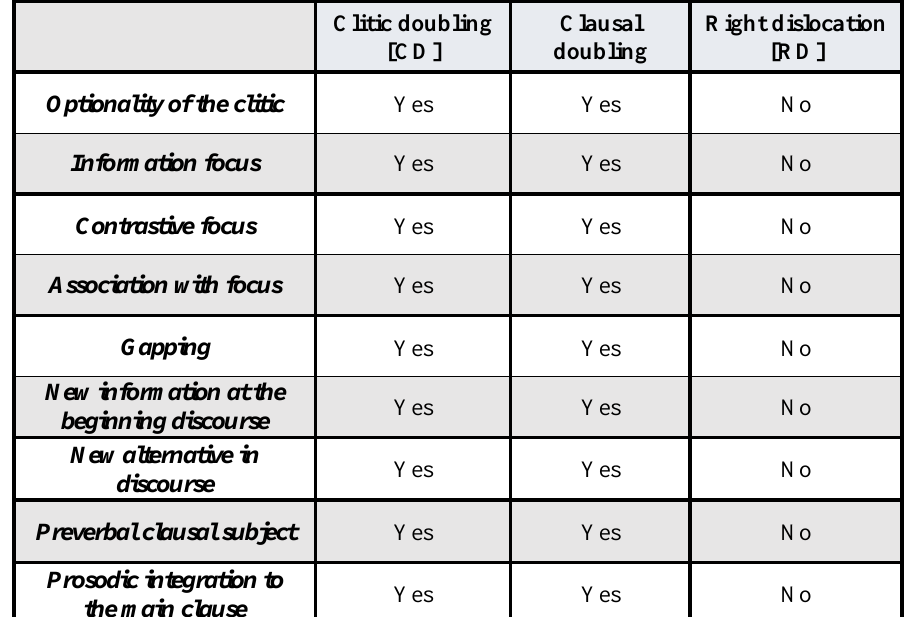
Table 1. Clitic doubling, clausal doubling and right